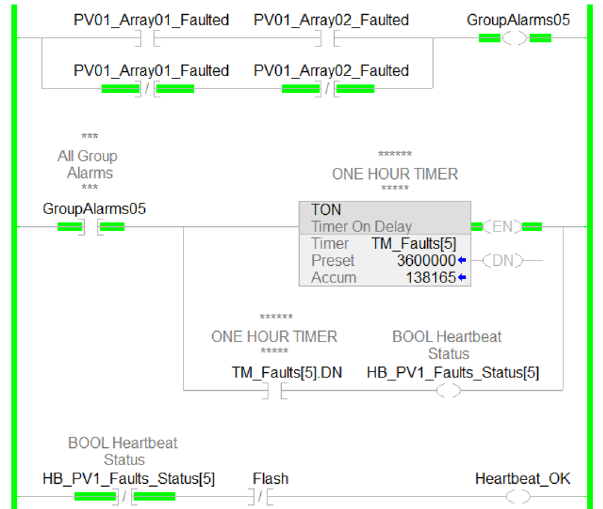
Fig. 26 Heartbeat setup based on alarms within a group